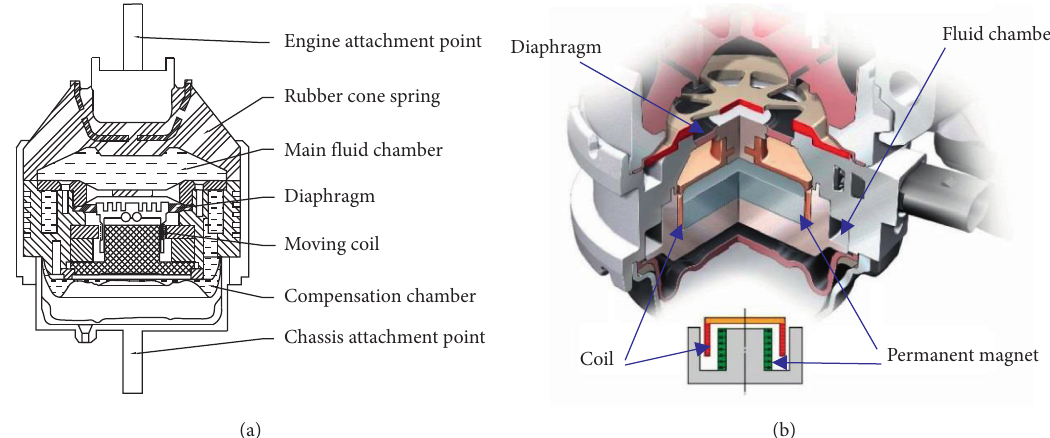
Figure 3: Electromagnetic AEM with a voice coil actuator: (a) AEM with a voice coil [51]; (b) AEM with a voice coil on the Audi S8 [4].